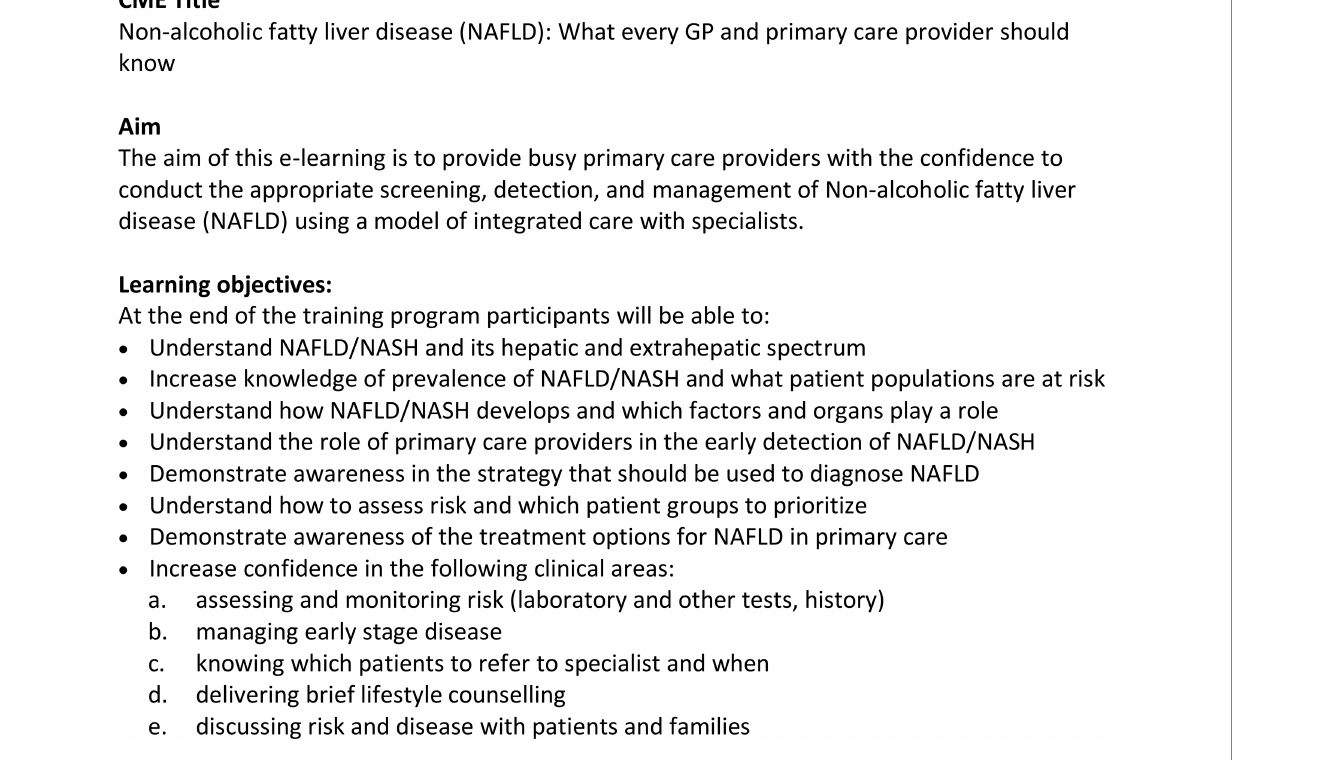
FIGURE 2 Title, aim, learning objectives, and content outline of the CME